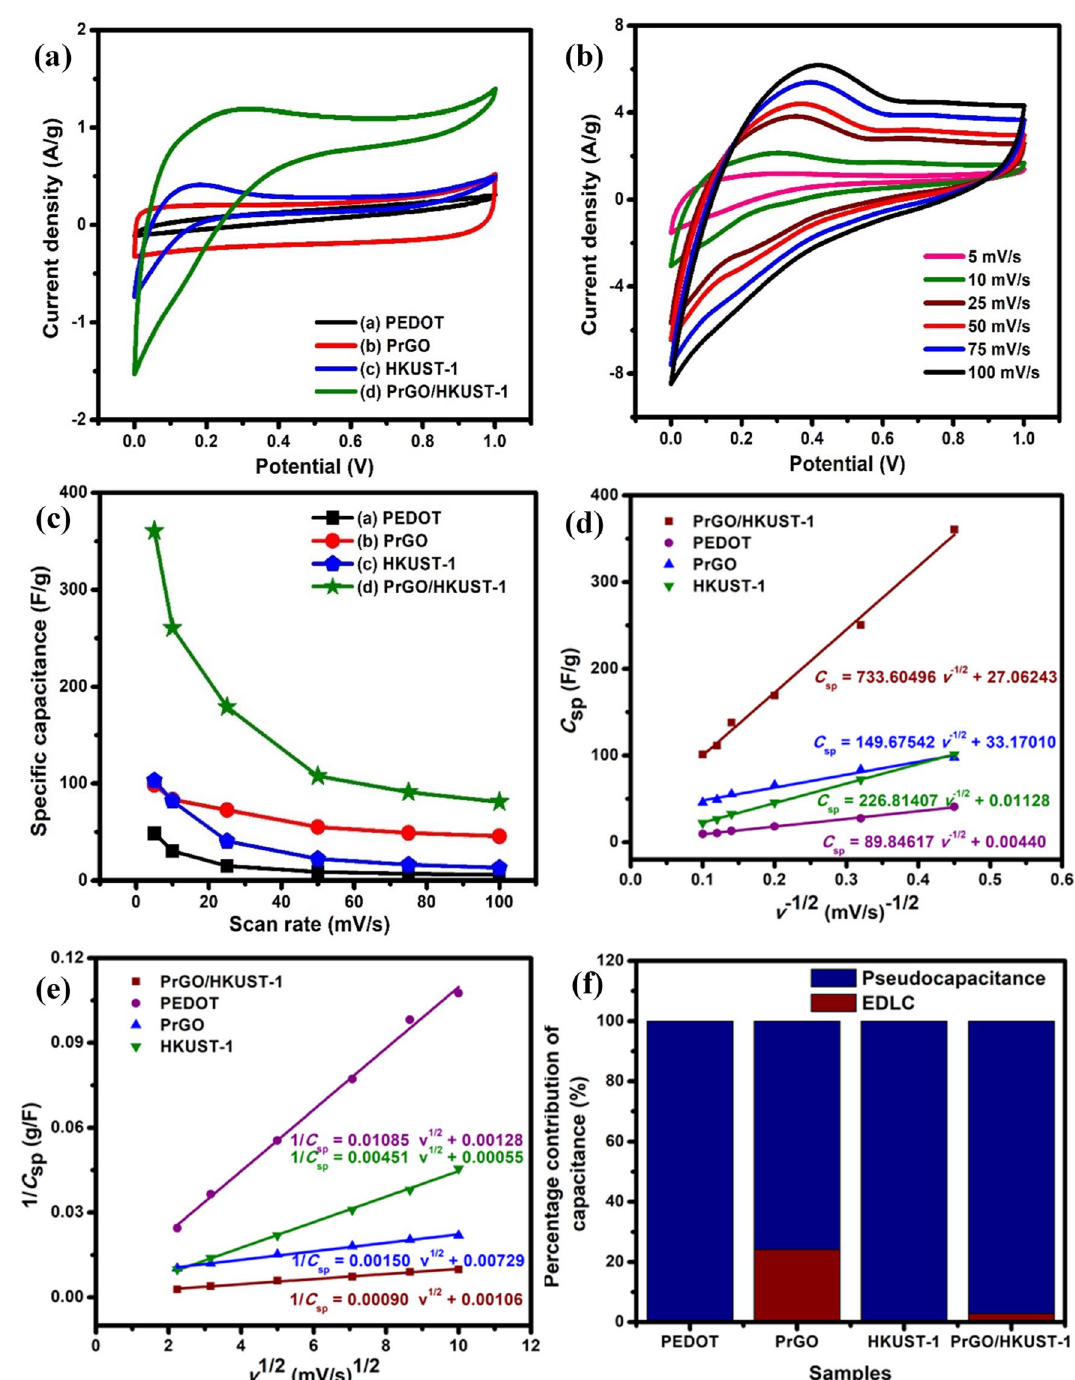
Figure 5. ( a ) CVs of PrGO, PEDOT, HKUST-1 and PrGO/HKUST-1 using KCl/PVA gel electrolyte at 5 mV/s, ( b ) CVs of symmetrical PrGO/HKUST-1 at different scan rates (5–100 mV/s). The graph of ( c ) specific capacitance versus scan rate, Trasatti plots of ( d ) C sp against 1/square root of scan rate (v −1/2 ), (e) 1/ C sp against v 1/2 and ( f ) percentage contribution of capacitance for PrGO, PEDOT, HKUST-1 and